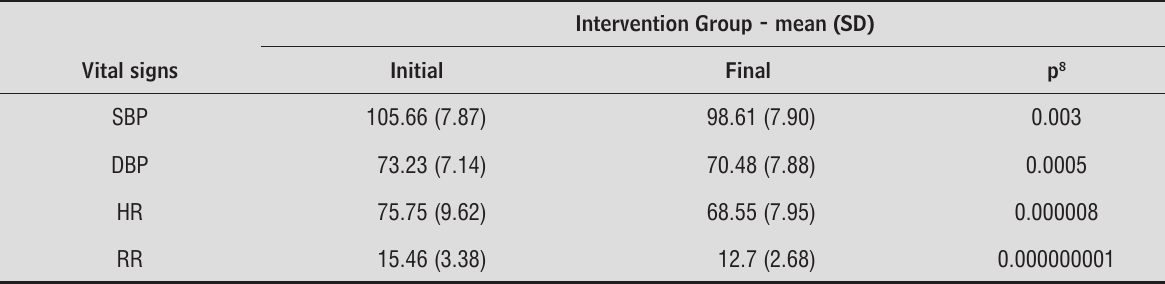
Table 5 - Distribution of initial and finals means and standard deviations (SD) of cardiorespiratory variables of the group with classical massage